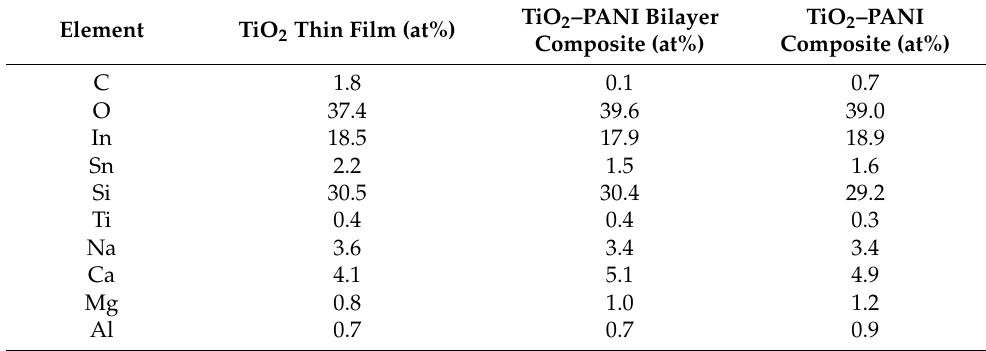
Figure 1. FESEM images and EDX spectra of ( a , d ) TiO 2 thin film; ( b , e ) TiO 2 –PANI bilayer composite; and ( c , f ) TiO 2 –PANI composite thin films. Table 1. EDX results of three thin films.